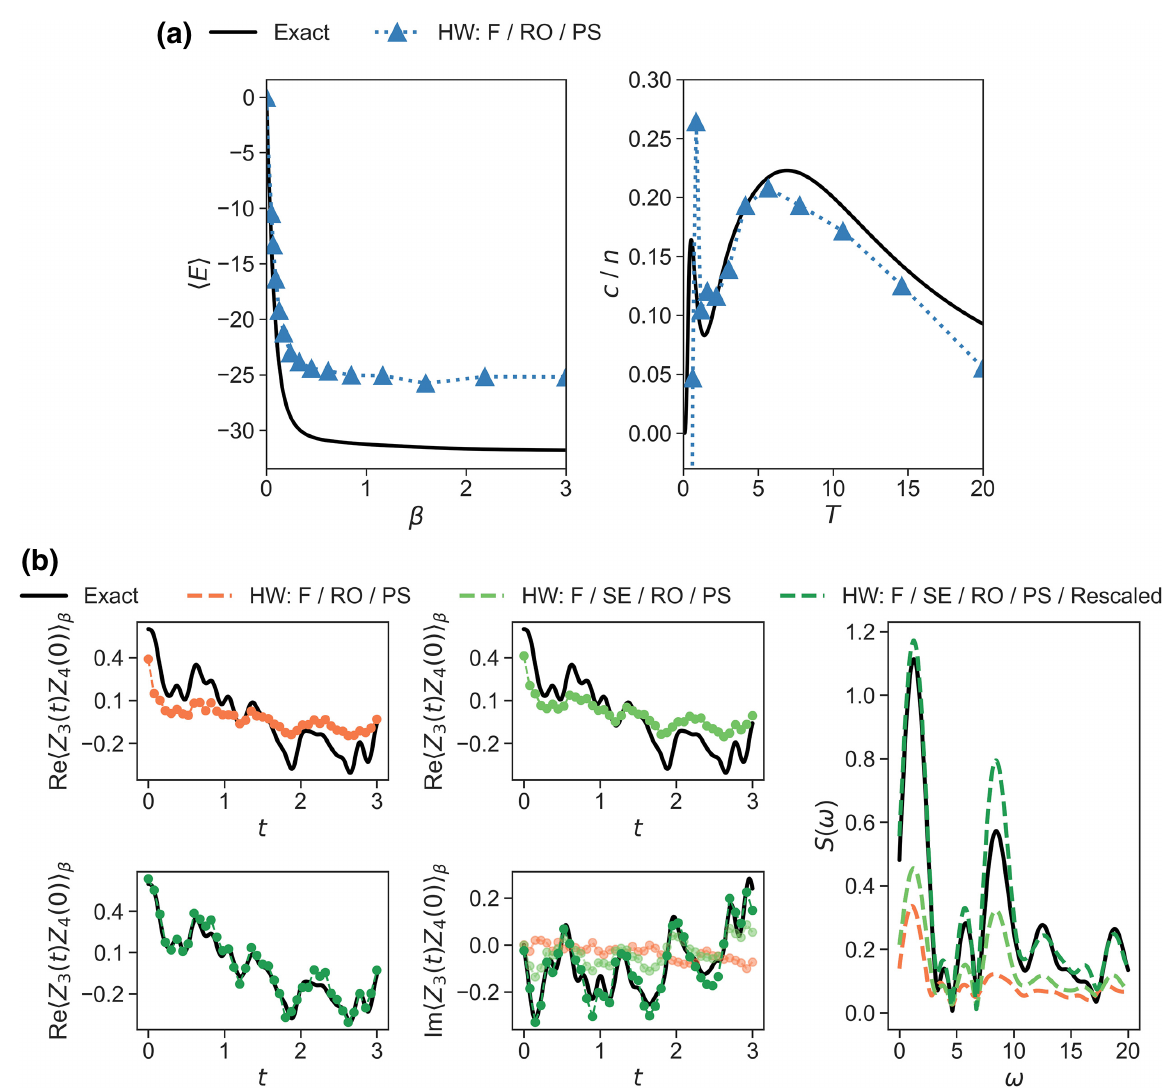
∂ (cid:2) E (cid:3) /∂ T ) for the α -RuCl = 6). The two-peak FIG. 4. (a) The thermal energy (cid:2) E (cid:3) and heat capacity ( c / n = 1 3 six-site model ( n n structure is indicative of the proximate spin-liquid character [29–31]. (b) The dynamical correlation function (cid:2) Z 3 ( t ) Z 4 ( 0 ) (cid:3) β and its transform S (ω) at β = 1 for the α -RuCl 3 six-site model. The three plots for the real part show the successive improvement obtained by standard error mitigation (Floquet, readout error, postselection, orange); the introduction of spin echoes (light green); and rescaling (dark green). The same is seen in the plots for the imaginary part and for S (ω) , where the results successively including these three classes of techniques are superposed. Error-mitigation acronyms: SE, spin echoes; F, Floquet calibration; RO, readout-error mitigation; PS, postselection; HW,